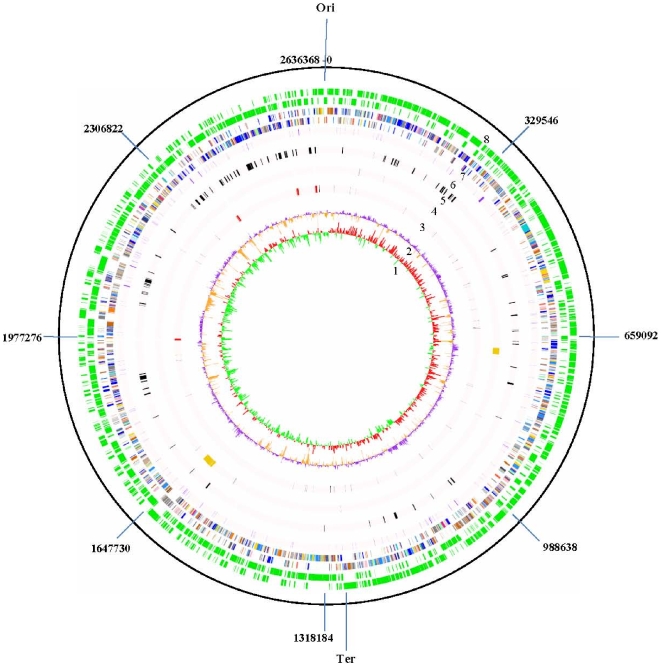
Circular genome map of B. dentium Bd1.From innermost circle, circle (1) illustrates GC skew (G−C/G+C), values >0 are in red and <0 in green. Circle (2) highlights G+C% deviation from the mean (58.54%). Circle (3) indicates rRNAs (depicted in red) and tRNAs (depicted in blue). Circle (4) denotes IS and prophages (depicted in orange). Circle (5) depicts genes involved in sugar metabolism according to the CAZY database. Circle (6) denotes conserved ORF distribution. Circle (7) shows coding regions by strand with color corresponding to the COG functional assignment (the color code used is the same indicated in Figure 2). Circle (8) displays the ORF distribution by strand.